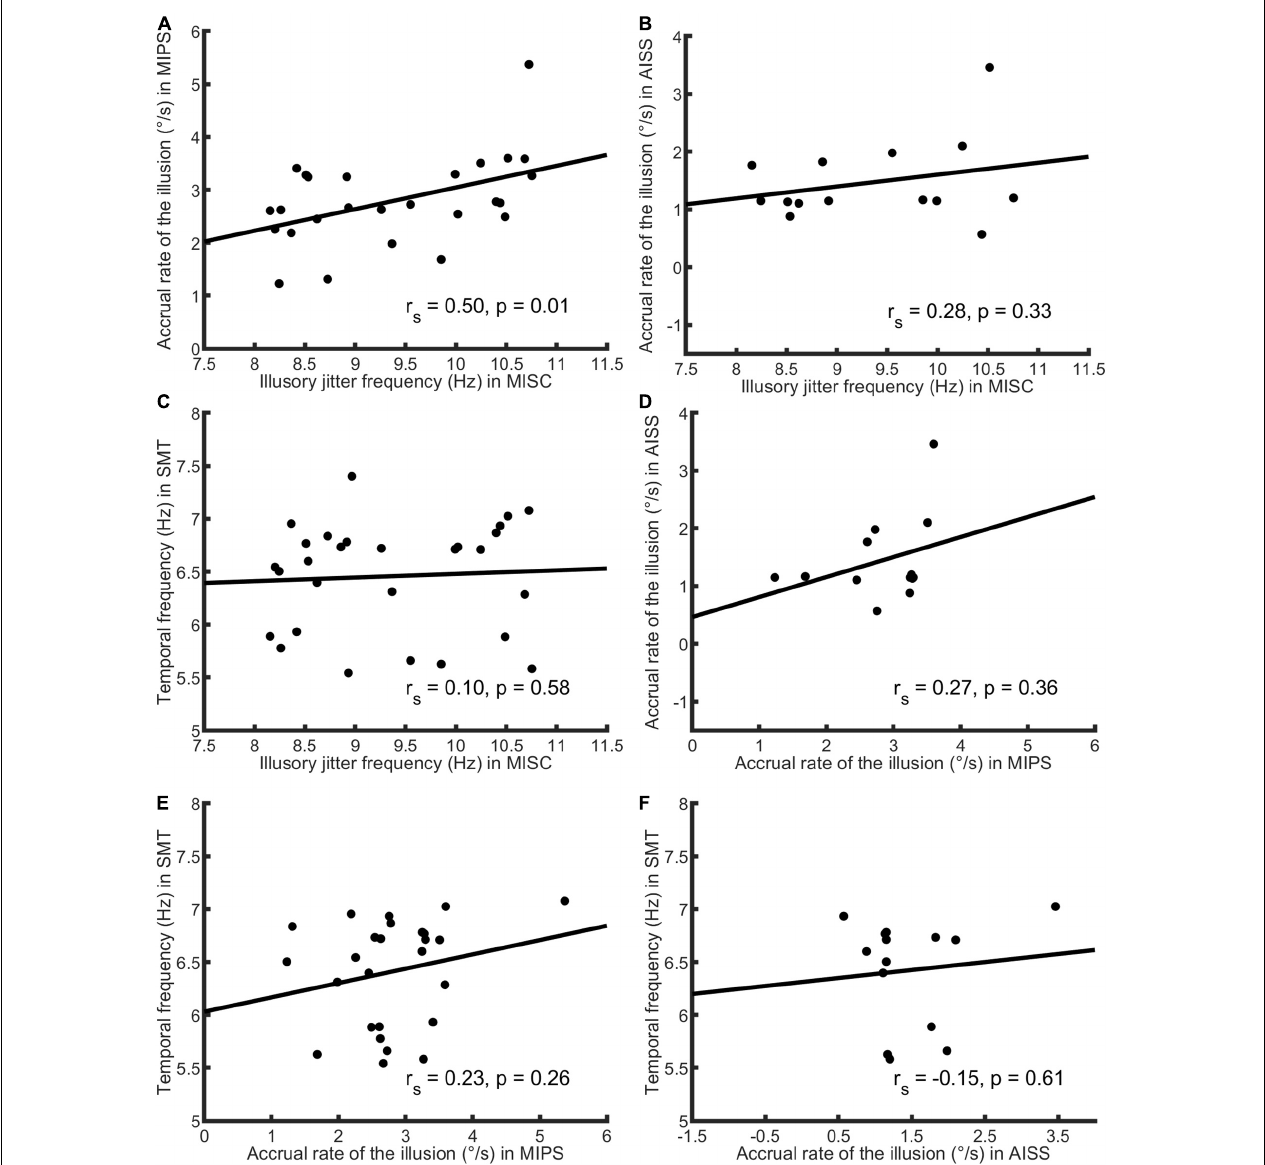
FIGURE 3 | Scatter plots of participant performance data for all pairings of the four tasks. Spearman’s r and p -value calculated by each paired data are shown in each figure. Only significant accrual rates in MIPS and AISS were used (see Figure 2 for details), and the sample size was 28 in the MISC and SMT task, 26 in MIPS, and 14 in AISS. (A) The plot of MISC and MIPS scores. The illusory jitter frequency in MISC and accrual rate in MIPS were significantly correlated ( N = 26). There seems to be an outlier for the MIPS data (5.37 ◦ /s, on the figure’s top-right corner). Although, Spearman’s correlation is rank-based and has an advantage of robustness to outliers, we also conducted the correlation analysis while excluding this outlier. The result was still significant (Spearman’s r = 0.44, p = 0.03, N = 25). (B) The plot of MISC and AISS scores. (C) The plot of MISC and SMT scores. (D) The plot of MIPS and AISS scores. (E) The plot of MIPS and SMT scores. (F) The plot of AISS and SMT scores. All correlations in (B–F) were non-significant. Note the lines through the data were fitted using linear regression, whereas Spearman’s correlation is based on rank order, and therefore the slopes and the signs of the r -values need not